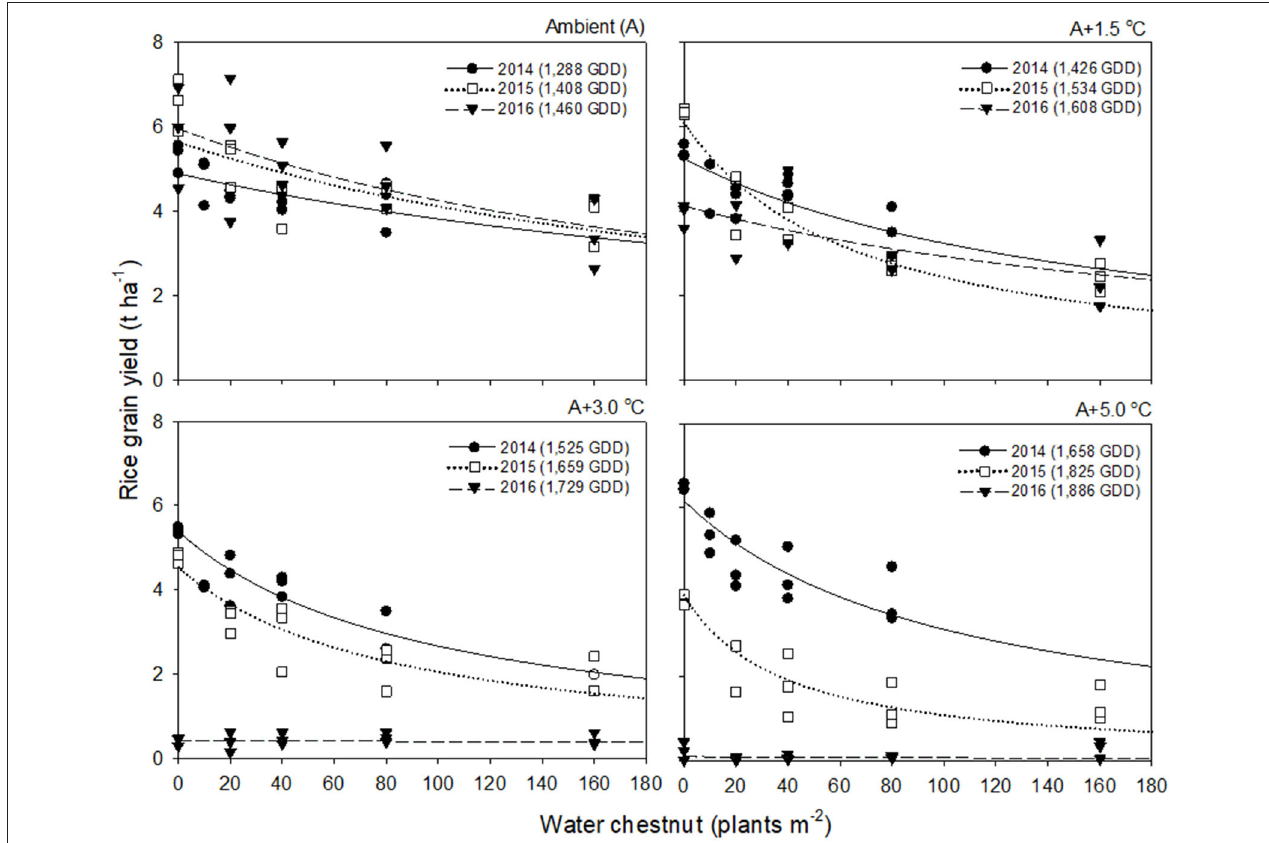
FIGURE 3 | Rice grain yield as a function of the weed density of water chestnut during accumulated growing degree days (GDD; from transplanting to flowering, 89 days) at four sunlit temperature-controlled phytotrons adjusted to ambient (A), A + 1.5 ◦ C, A + 3.0 ◦ C, and A + 5.0 ◦ C in 2014 ( • ), 2015 ( (cid:3) ), and 2016 ( H ). The lines are fitted values calculated, using the rectangular hyperbolic model (equation 3) and parameter estimates ( Table 2